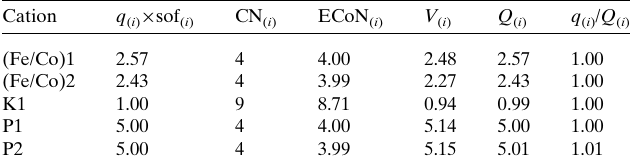
Figure 1 The principal building units in the crystal structure of (cid:2) -KCoFe(PO 4 ) 2 . Displacement ellipsoids are drawn at the 50% probability level. [Symmetry codes: (i) x , y , z + 1; (ii) x , (cid:2) y , z + 1 (iv) (cid:2) x , y , (cid:2) z + 1 (cid:2) y + 1